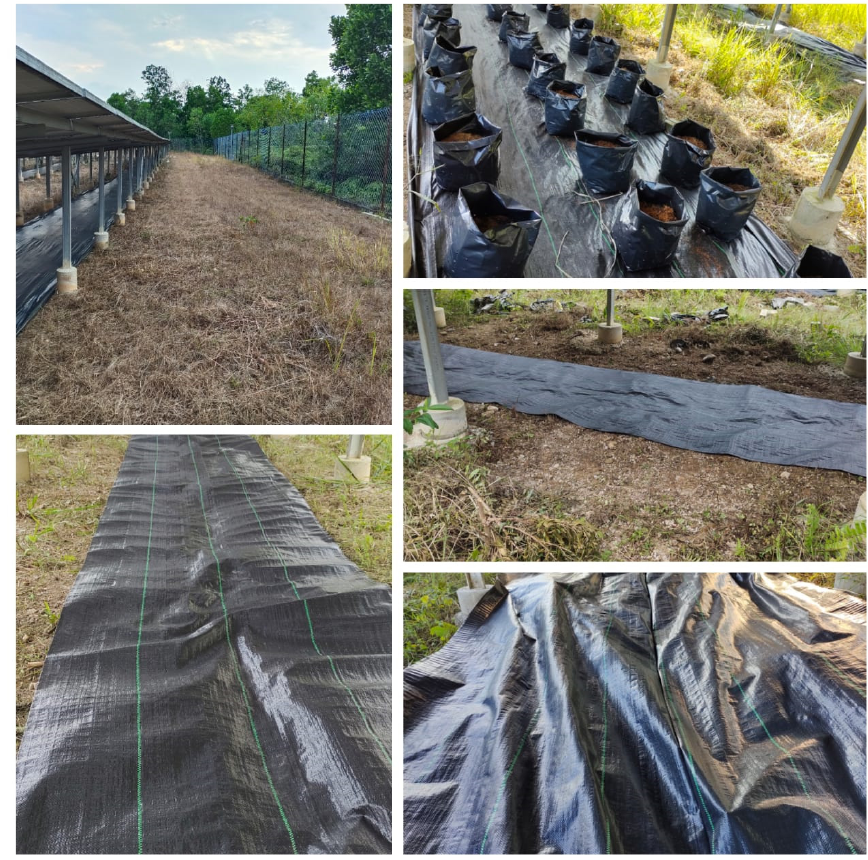
Figure 9. High-quality weed mats have been used as weed control measures directly under solar PV arrays for further crop cultivation.